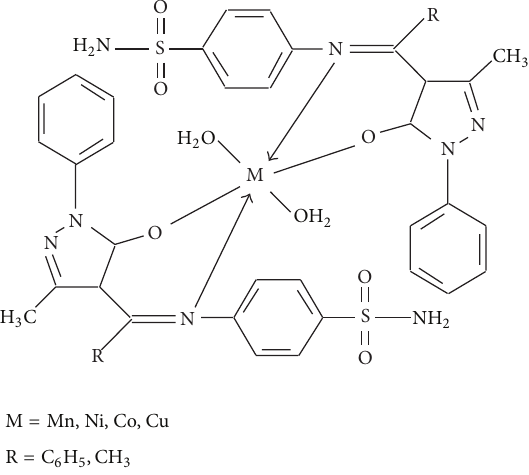
Figure 12: Proposed structural scheme for metal complexes.